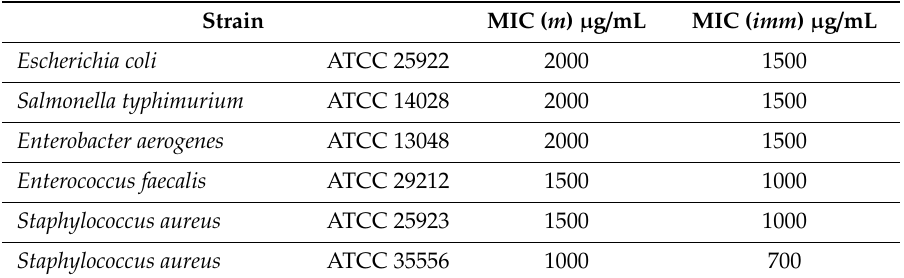
Table 4. Minimal inhibitory concentrations (MIC) of Opuntia ficus-indica mature ( m ) and immature cladode extracts ( imm ) against selected bacterial